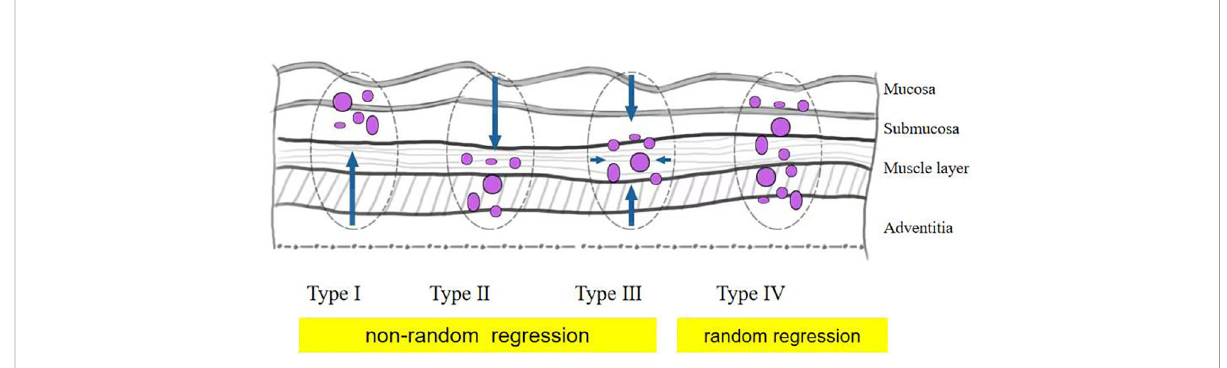
FIGURE 1 Schematic diagram of tumor regression pattern including type I, type II, type III, and type